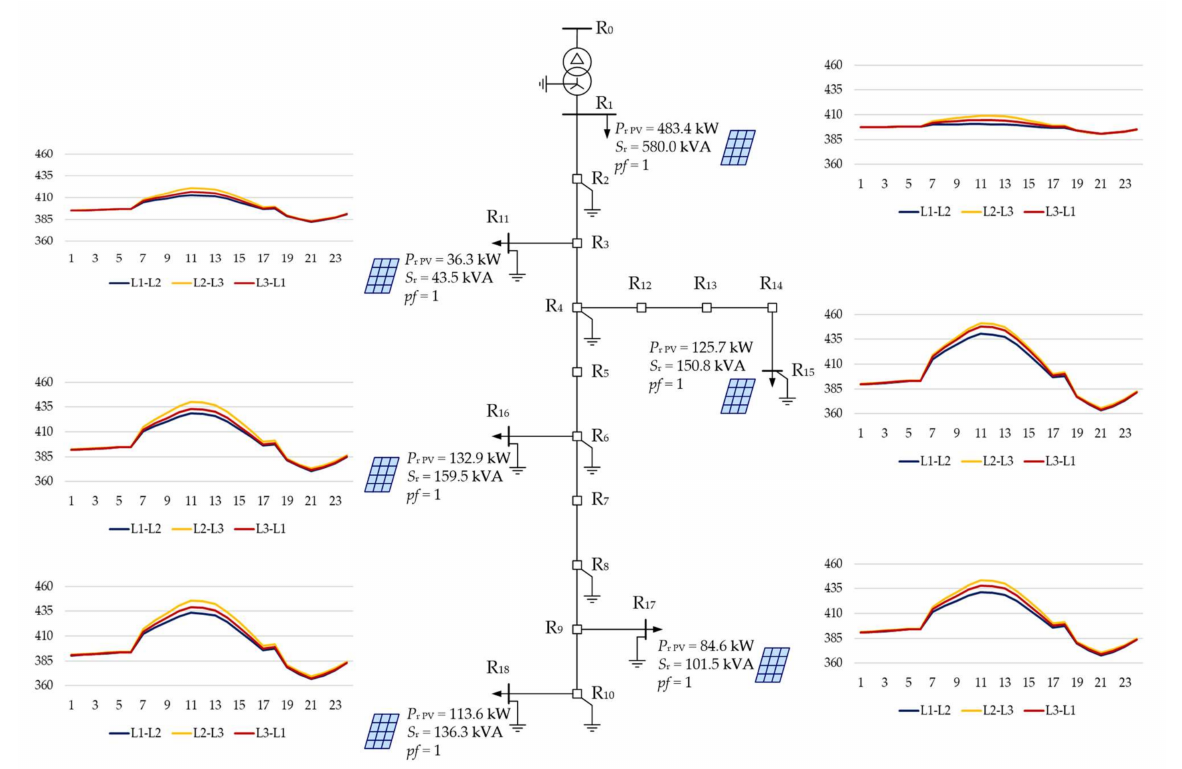
Figure A3. Daily simulation results for variant V5: phase-to-phase voltages (V).